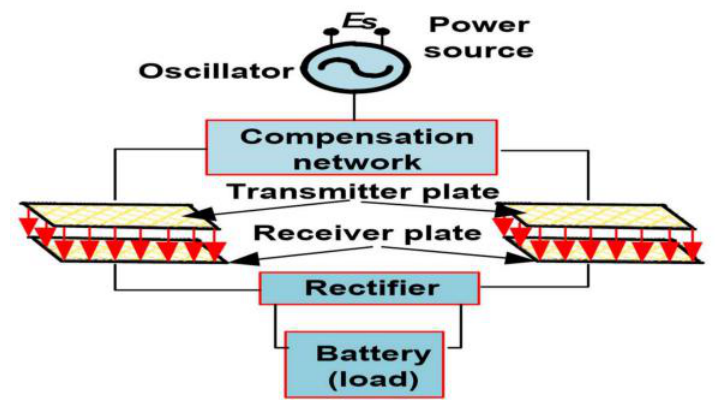
Figure 1. The basic longitudinal capacitive